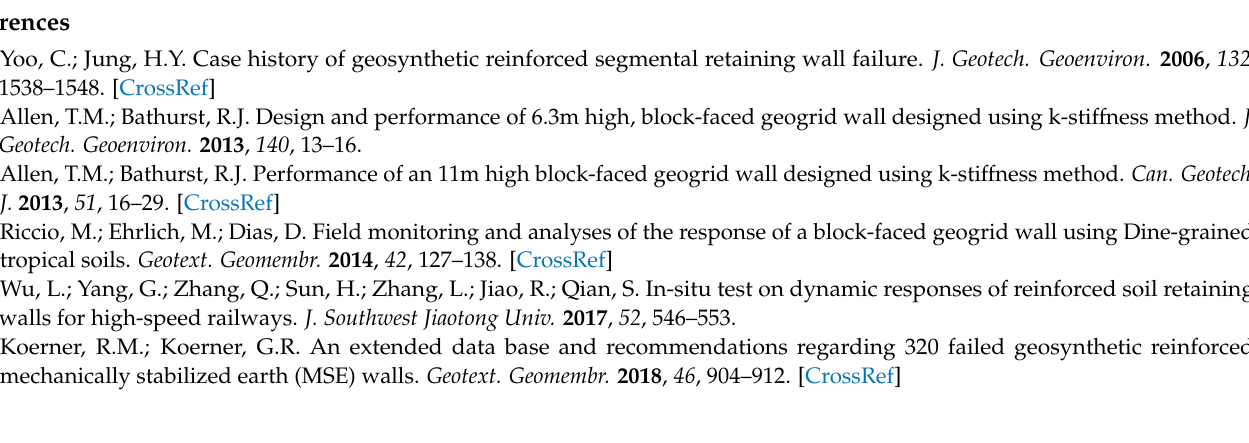
loading, Table S2: Reinforced soil retaining wall parameters of 10 case histories, Table S3: Measured and predicted maximum lateral deformations of GRS walls, Table S4: Introduction of the yield acceleration, Table S5: Calculation method of the horizontal displacement for the retaining wall under earthquake action. Reference [34] refer to the supplementary